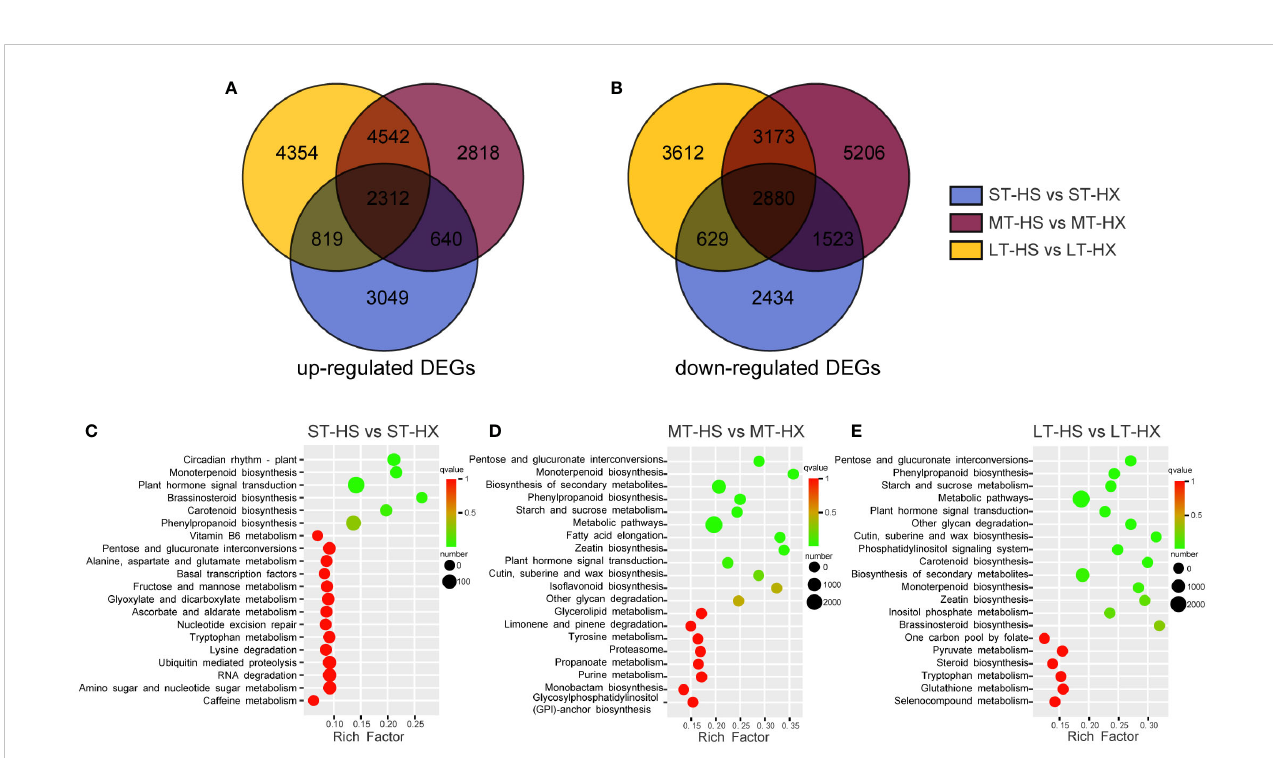
FIGURE 5 DEG analysis. The Venn diagram shows DEGs that were (A) up regulated or (B) down regulated; KEGG enrichment analysis of DEGs after (C) 1, (D) 7, and (E) 25 days of cold stress